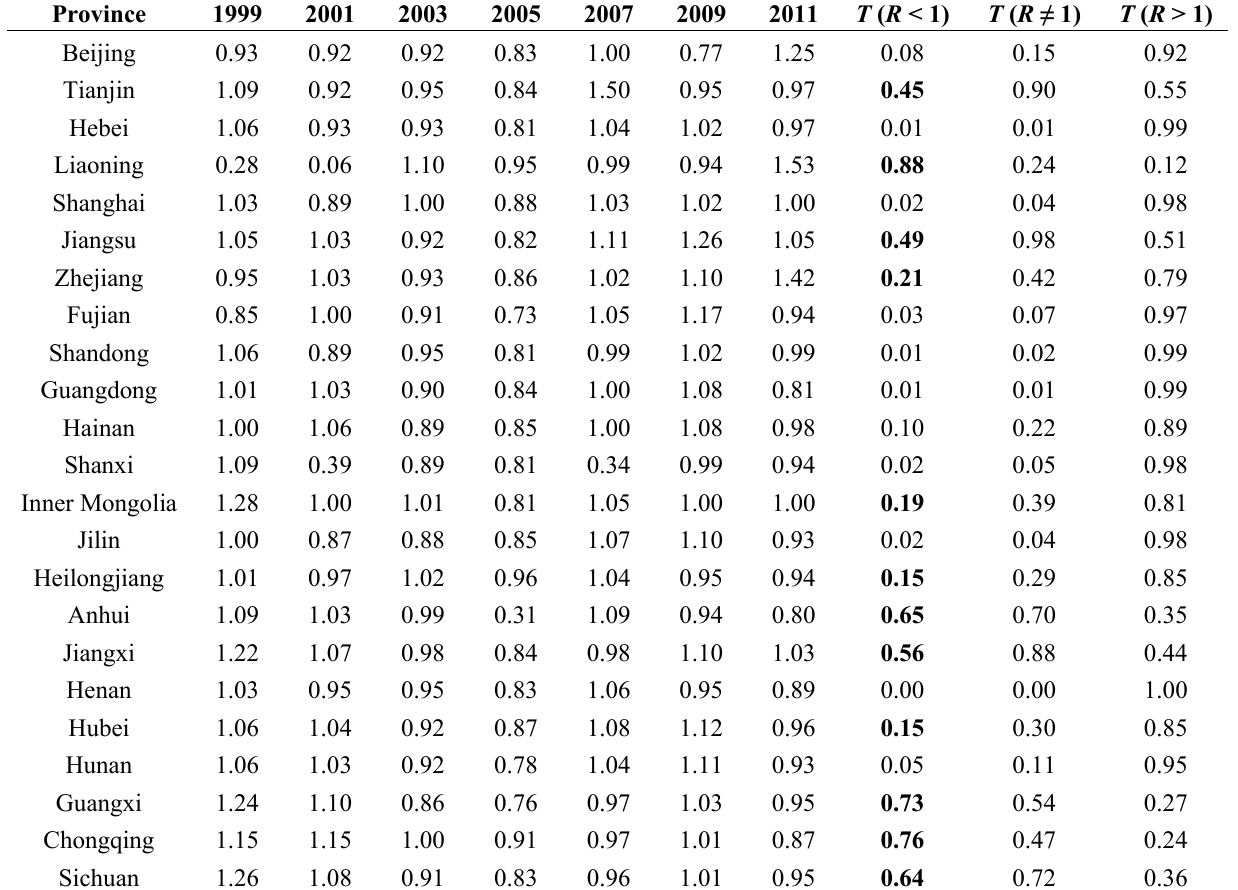
Table 2. Ratio of shadow price to market price for energy in